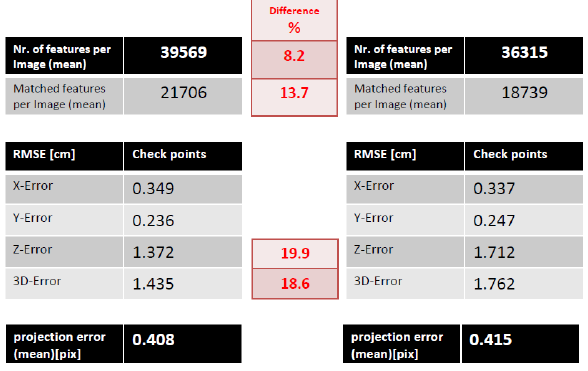
Figure 7. Simulated effects of image sharpness on bundle block adjustment for original images (left), blurred images (right) and corresponding differences